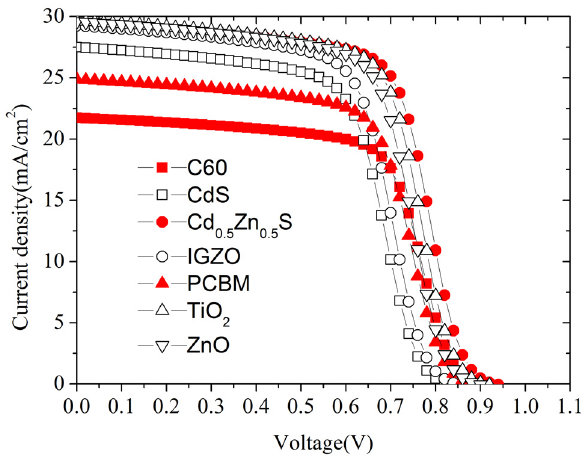
Figure 2. E ff ect of di ff erent ETL materials on J-V Figure 2. Effect of different ETL materials on J-V characteristics.